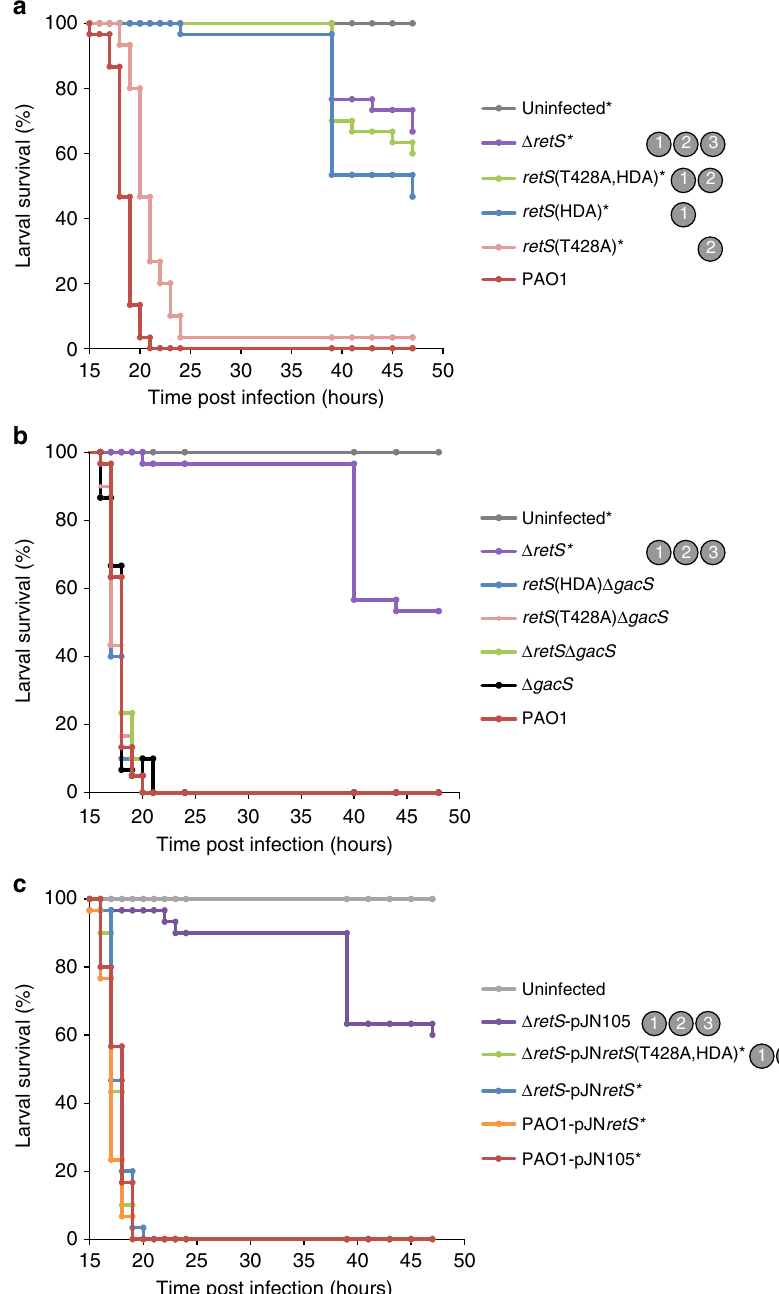
mice infected with the Δ retS mutant or the mutant lacking mechanism 1 ( retS (HDA)) survived for the 7-day duration of the experiment, demonstrating that RetS and mechanism 1 are essential for virulence (Fig. 5). The retS (T428A) mutant, which